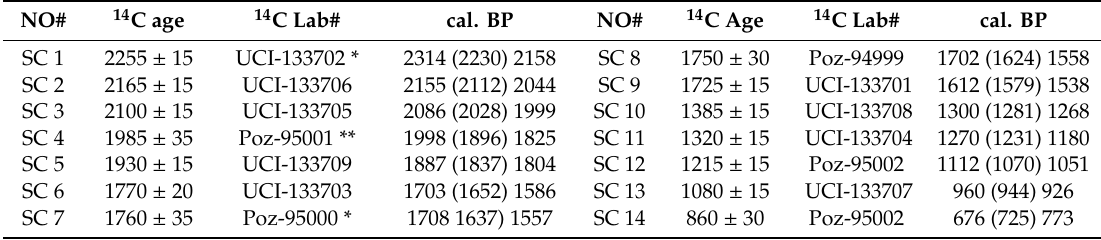
Table A3. Radiocarbon Dates from Trunks Incorporated Within the Terminal Moraine Deposits of Schiaparelli